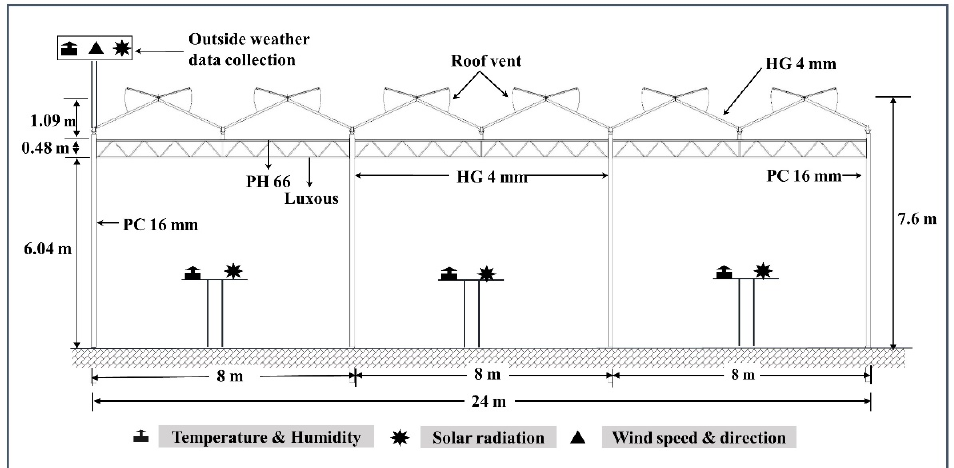
Figure 2. Experimental greenhouse’s layout.